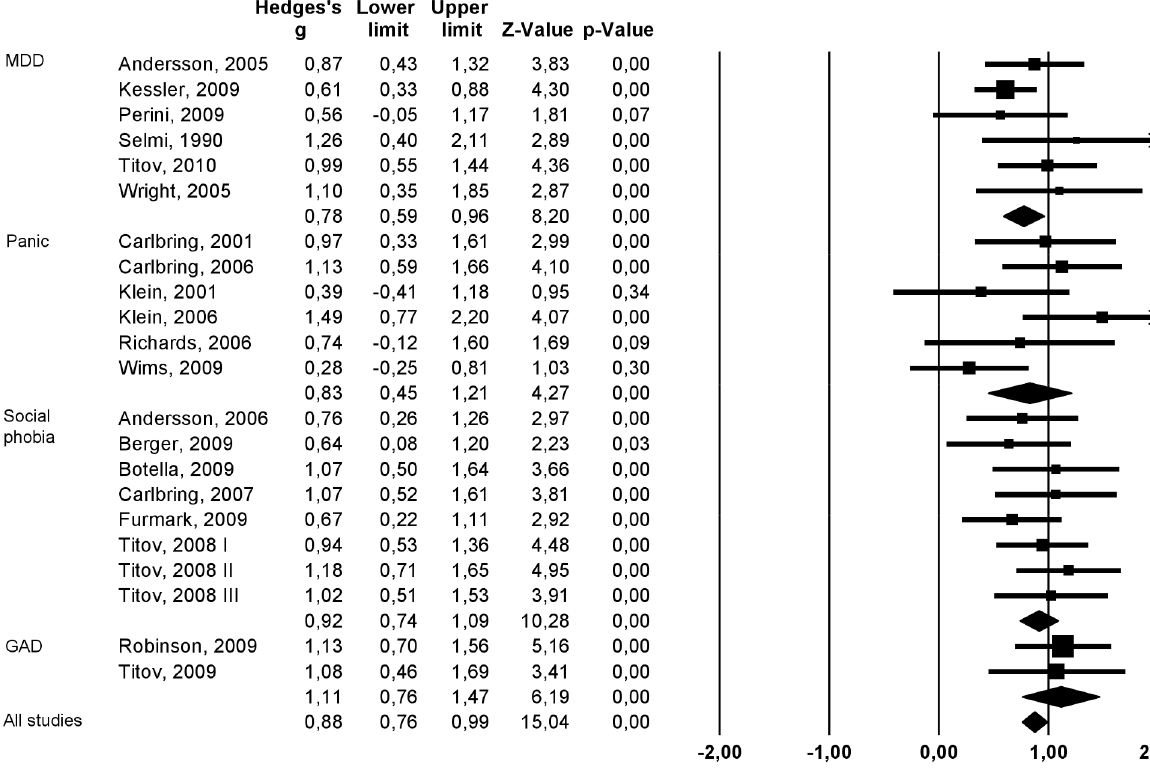
Figure 1. Effect sizes of Computerised CBT versus control conditions at post-test.